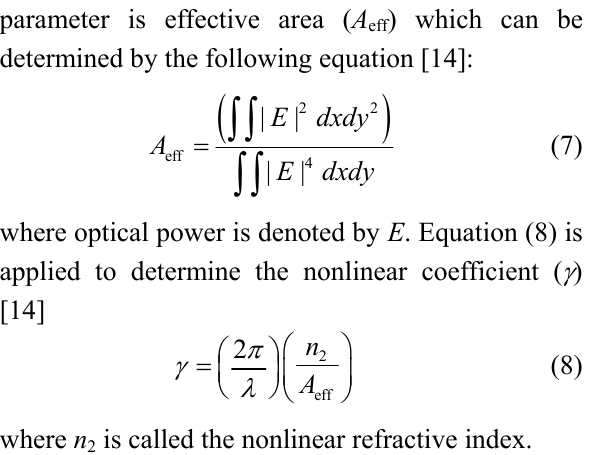
Fig. 2 Modal intensity distribution of the proposed H-PCF at the wavelength of 1.33  m: (a) x -polarization and (b) y -polarization.